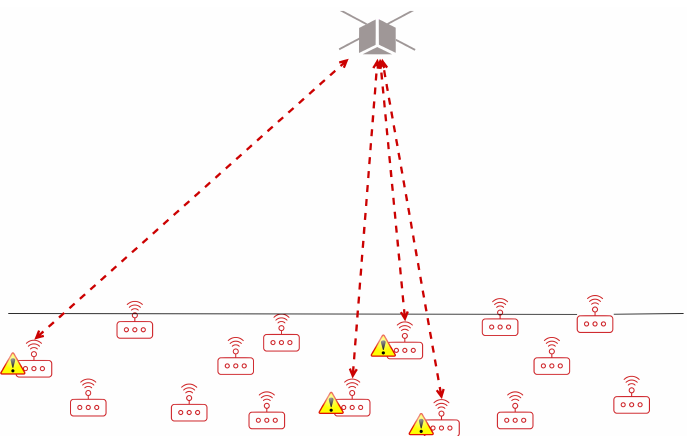
Figure 1. Visual representation of the on-demand satellite payload execution